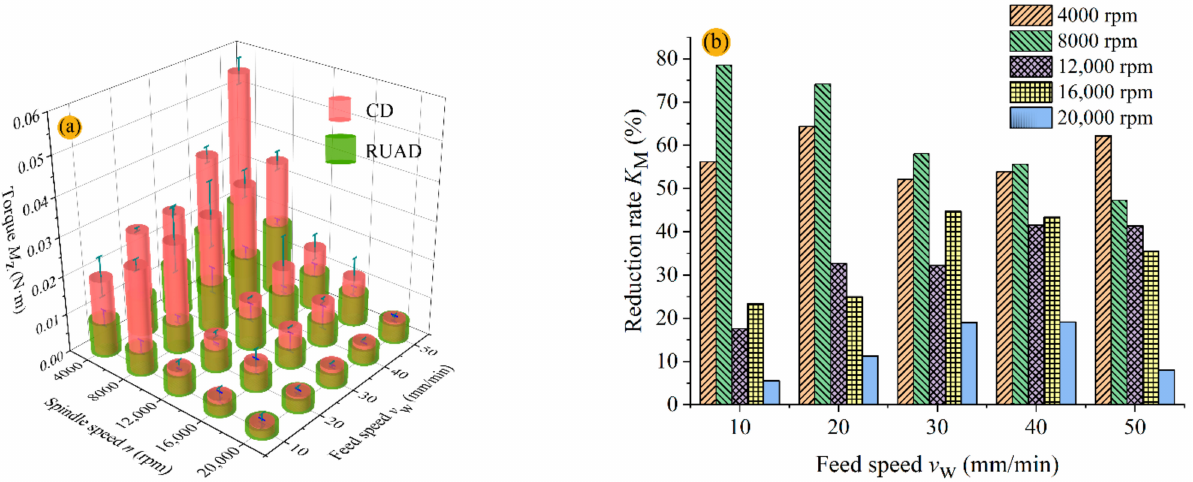
Figure 9. Effect of different machining parameters on torque, ( a ) variation trend of torque, ( b ) varia- tion trend K M of torque